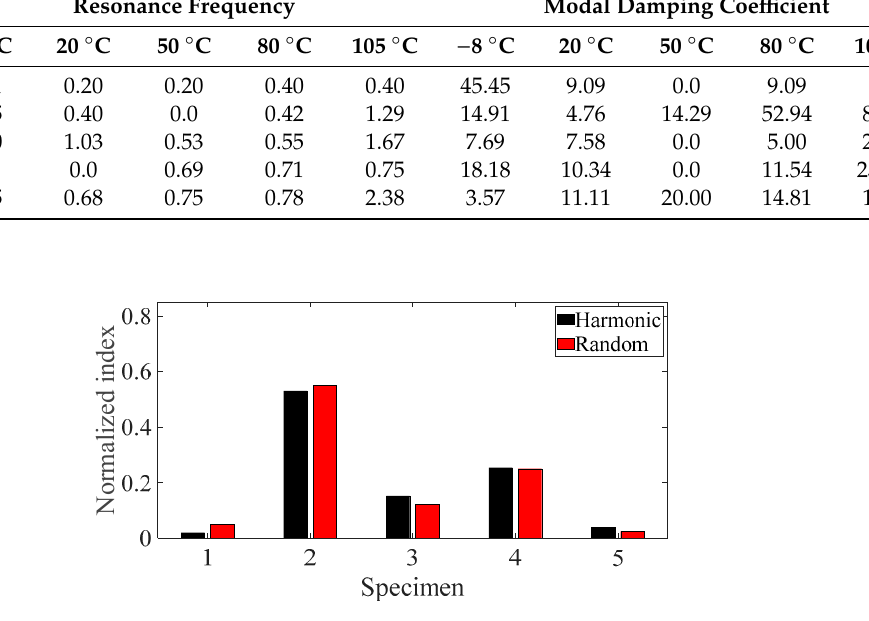
Figure 14. Normalized sensitivity index for the direction of carbon fiber for the two spectral loading cases.